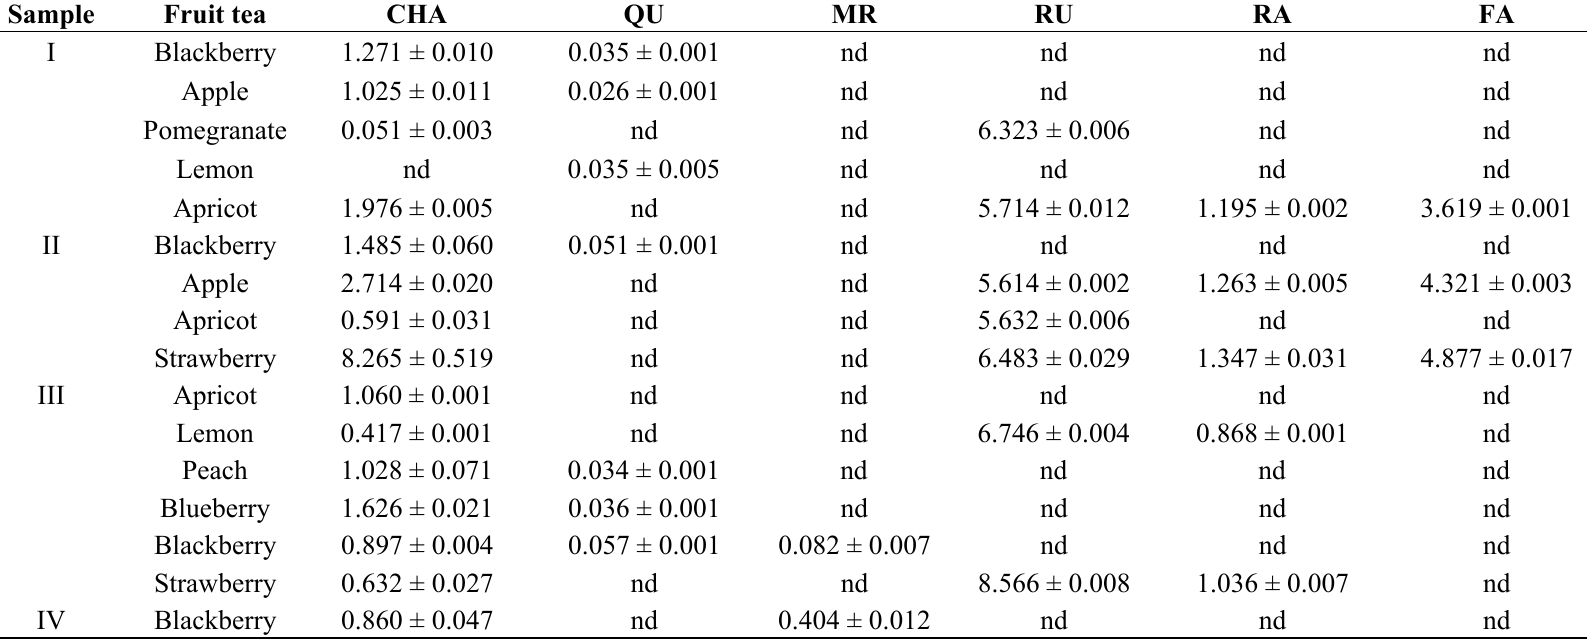
Mean of two determinations ± SD. nd not detected, CHA chlorogenic acid, QU quercetin, MR myricetin, RU rutin, RA rosmarinic acid, FA ferulic acid, SD standard